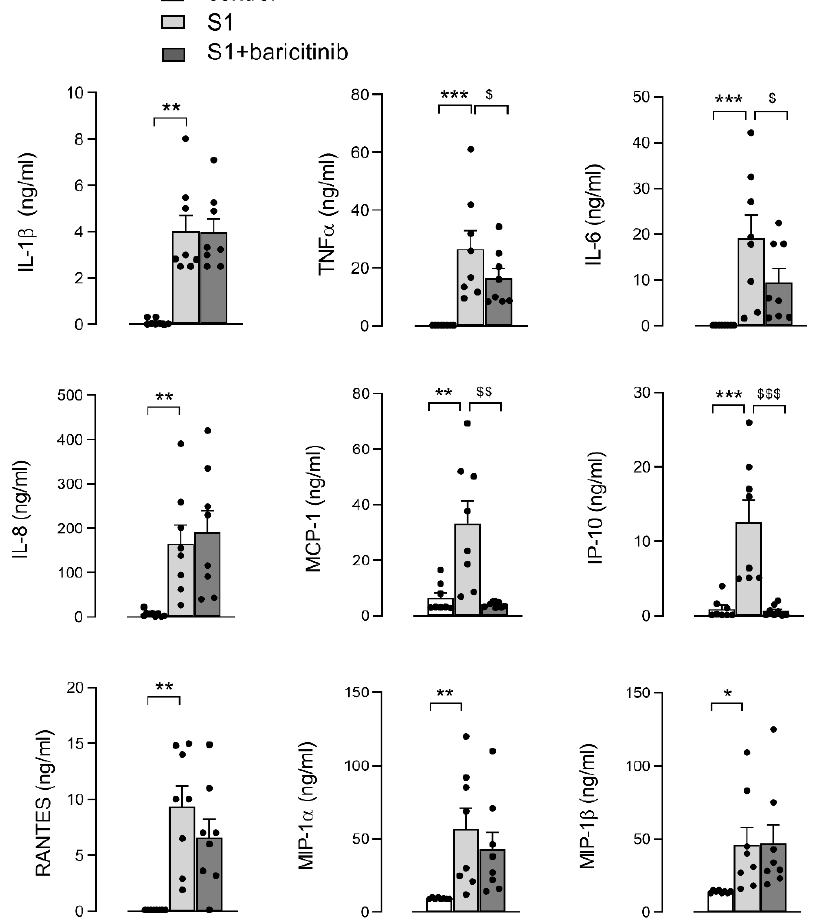
Figure 2. MDM were left untreated (control) or incubated for 24 h with 5 nM spike S1 protein in the absence (S1) or in the presence of 1 µM baricitinib (S1+baricitinib). Cytokines released in the medium were quantified with an ELISA assay, as described in Materials and Methods. Bars are means ± SEM of eight independent experiments (single dots). * p < 0.05, ** p < 0.01, *** p < 0.001 vs. untreated cells